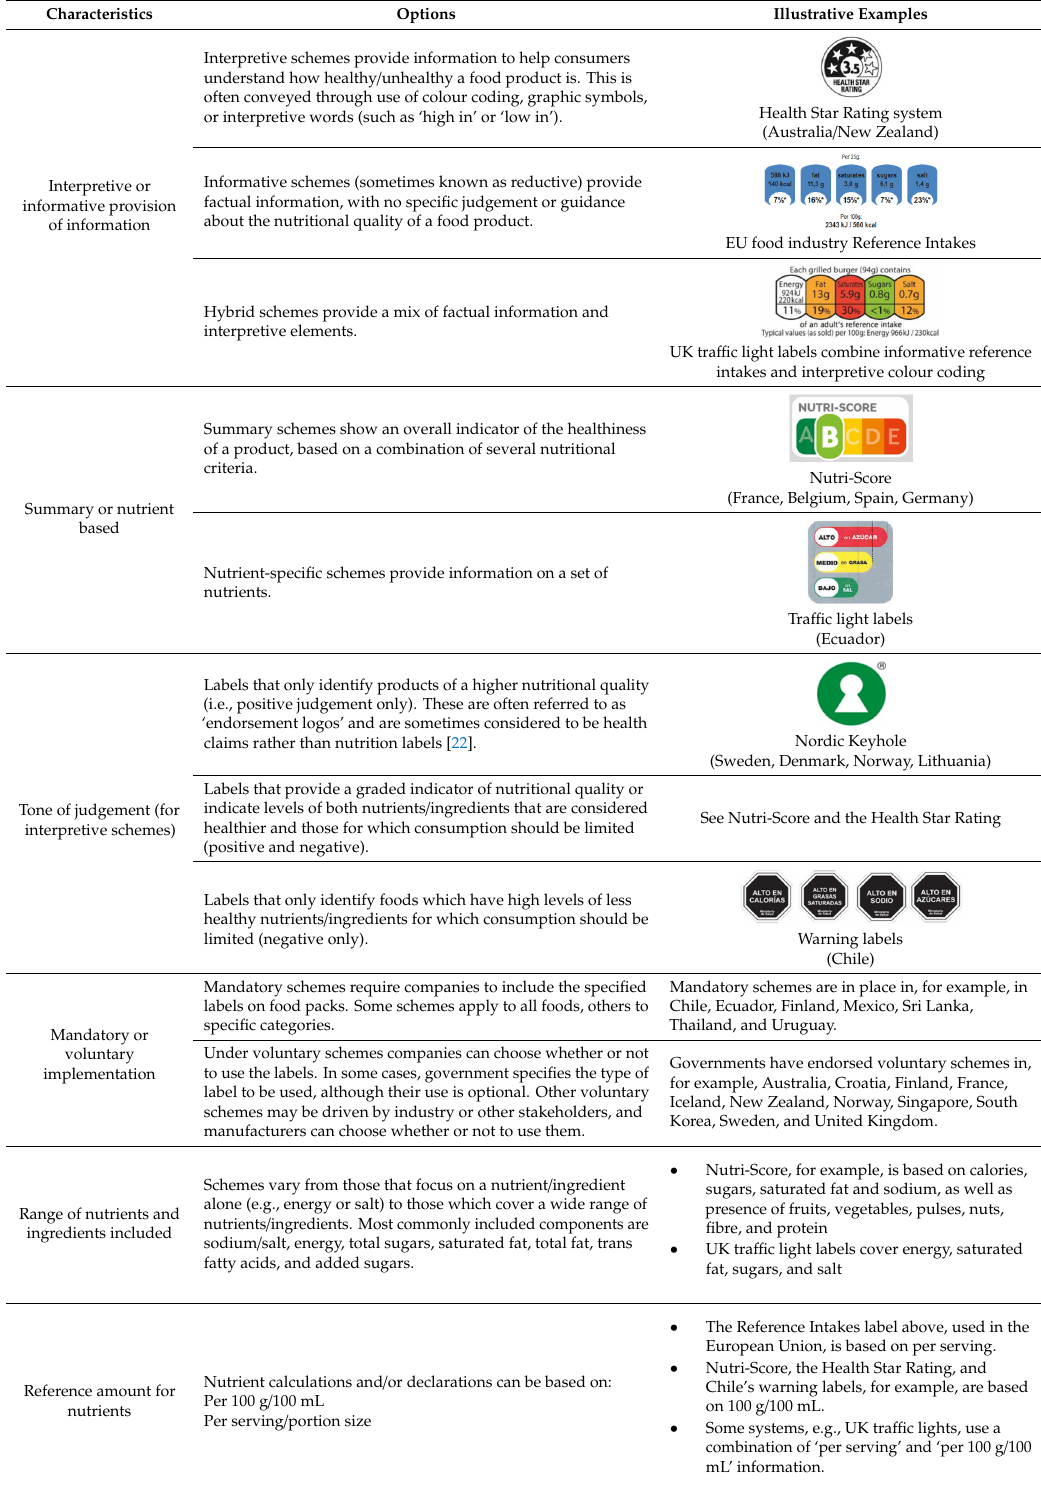
Table 1. Key characteristics for categorizing front-of-pack labelling schemes.